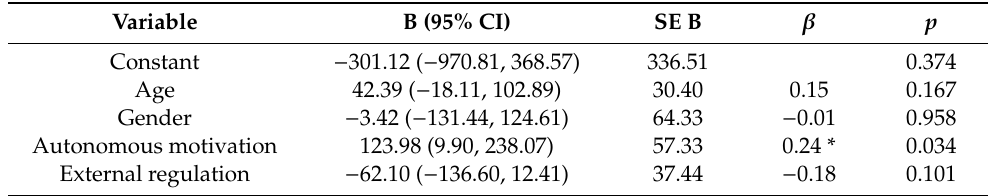
Table 4. Simultaneous multiple regression analysis exploring the relationship between Moderate-to- vigorous Physical Activity (MVPA) and Behavioural Regulation in Exercise Questionnaire (BREQ) autonomous motivation and external regulation for exercise scores. Variable B (95%